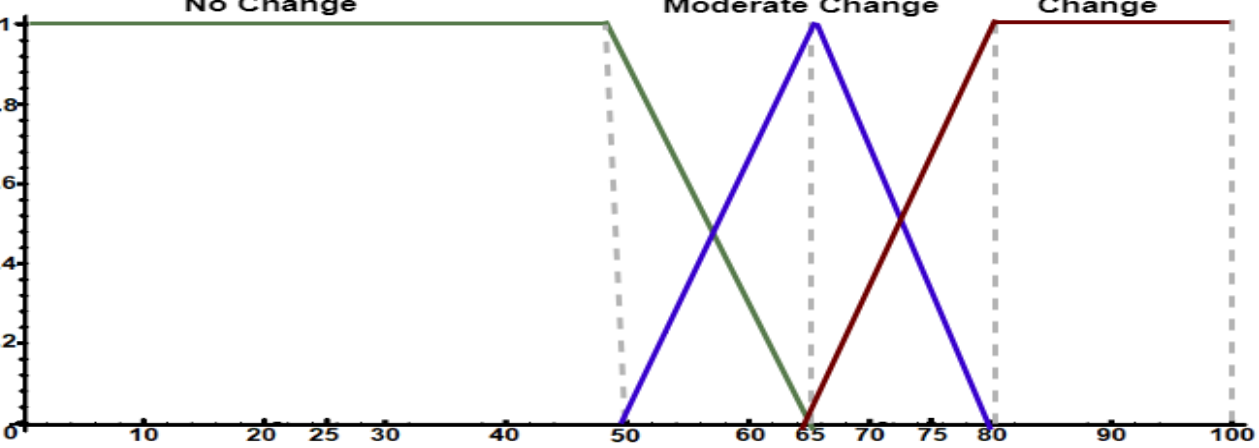
Figure 7. Output fuzzy sets defined to assess behavior